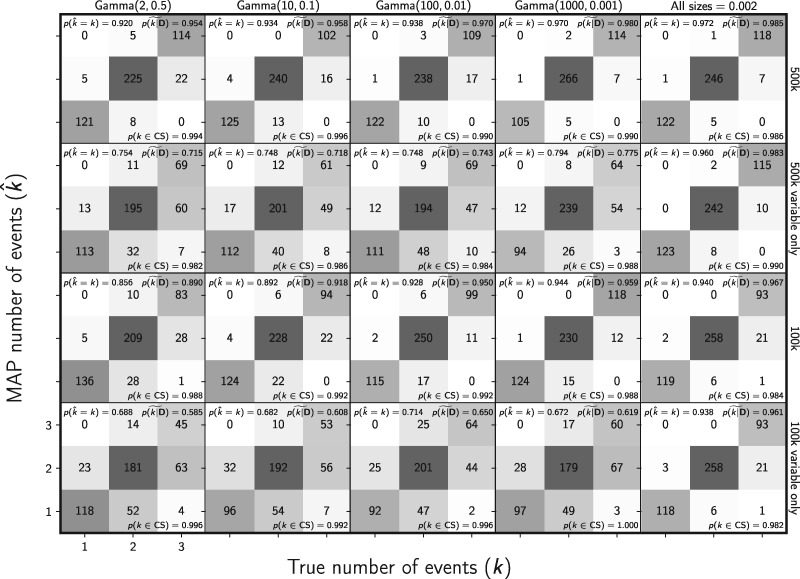
The ability of the new method to estimate the number of divergence events when data are simulated and analyzed under the same model (i.e., no model misspecification). The first four columns show the results from different distributions on the relative effective size of the ancestral population, decreasing in variance from left to right. The fifth column shows results when the effective size (\documentclass[12pt]{minimal}
\usepackage{amsmath}
\usepackage{wasysym}
\usepackage{amsfonts}
\usepackage{amssymb}
\usepackage{amsbsy}
\usepackage{upgreek}
\usepackage{mathrsfs}
\setlength{\oddsidemargin}{-69pt}
\begin{document}
}{}$N_{e}{\mu}$\end{document}) of all populations is fixed to 0.002. For the first two and last two rows, the simulated character matrix for each population had 500,000 and 100,000 characters, respectively. The first and third rows show the results of analyses using all characters, whereas the second and fourth rows show the results when only variable characters are used. Each plot shows the results of the analyses of 500 simulated data sets, each with three population pairs; the number of data sets that fall within each possible cell of true versus estimated numbers of events is shown, and cells with more data sets are shaded darker. The estimates are based on the number of events with the maximum a posteriori (MAP) probability. For each plot, the proportion of data sets for which the number of events with the largest posterior probability matched the true number of events—\documentclass[12pt]{minimal}
\usepackage{amsmath}
\usepackage{wasysym}
\usepackage{amsfonts}
\usepackage{amssymb}
\usepackage{amsbsy}
\usepackage{upgreek}
\usepackage{mathrsfs}
\setlength{\oddsidemargin}{-69pt}
\begin{document}
}{}$p(\hat{{k}} = {k})$\end{document}—is shown in the upper left corner, the median posterior probability of the correct number of events across all data sets—\documentclass[12pt]{minimal}
\usepackage{amsmath}
\usepackage{wasysym}
\usepackage{amsfonts}
\usepackage{amssymb}
\usepackage{amsbsy}
\usepackage{upgreek}
\usepackage{mathrsfs}
\setlength{\oddsidemargin}{-69pt}
\begin{document}
}{}$\widetilde{p({k}|{\mathbf{D}})}$\end{document}—is shown in the upper right corner, and the proportion of data sets for which the true number of events was included in the 95% credible set—\documentclass[12pt]{minimal}
\usepackage{amsmath}
\usepackage{wasysym}
\usepackage{amsfonts}
\usepackage{amssymb}
\usepackage{amsbsy}
\usepackage{upgreek}
\usepackage{mathrsfs}
\setlength{\oddsidemargin}{-69pt}
\begin{document}
}{}$p({k} \in \textrm{CS})$\end{document}—is shown in the lower right. We generated the plot using matplotlib Version 2.0.0 (Hunter 2007)